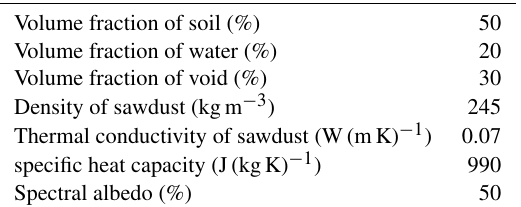
Table 2. Initial properties of the sawdust cover layer. Note that SNOWPACK characterizes soil and other layers with the volume fractions of the dry material, the void and the water fractions. The properties of the dry material are partly based on measurements and partly on experience (e.g. Rinderer, 2009).